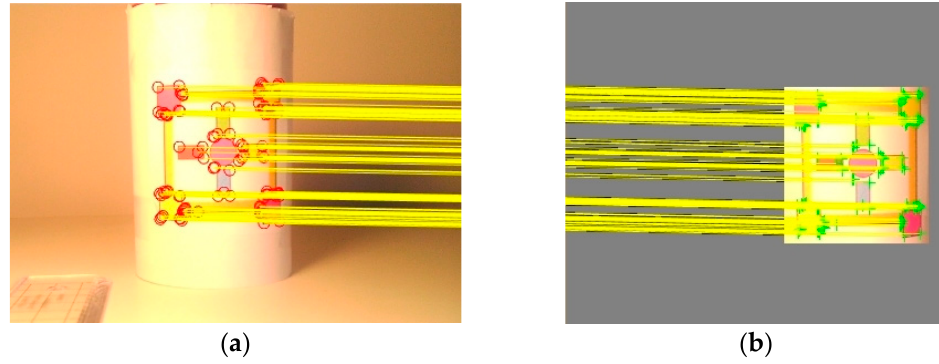
Figure 4. A successful recognition example showing all matches. ( a ) Features on real image; ( b ) features on reference image.